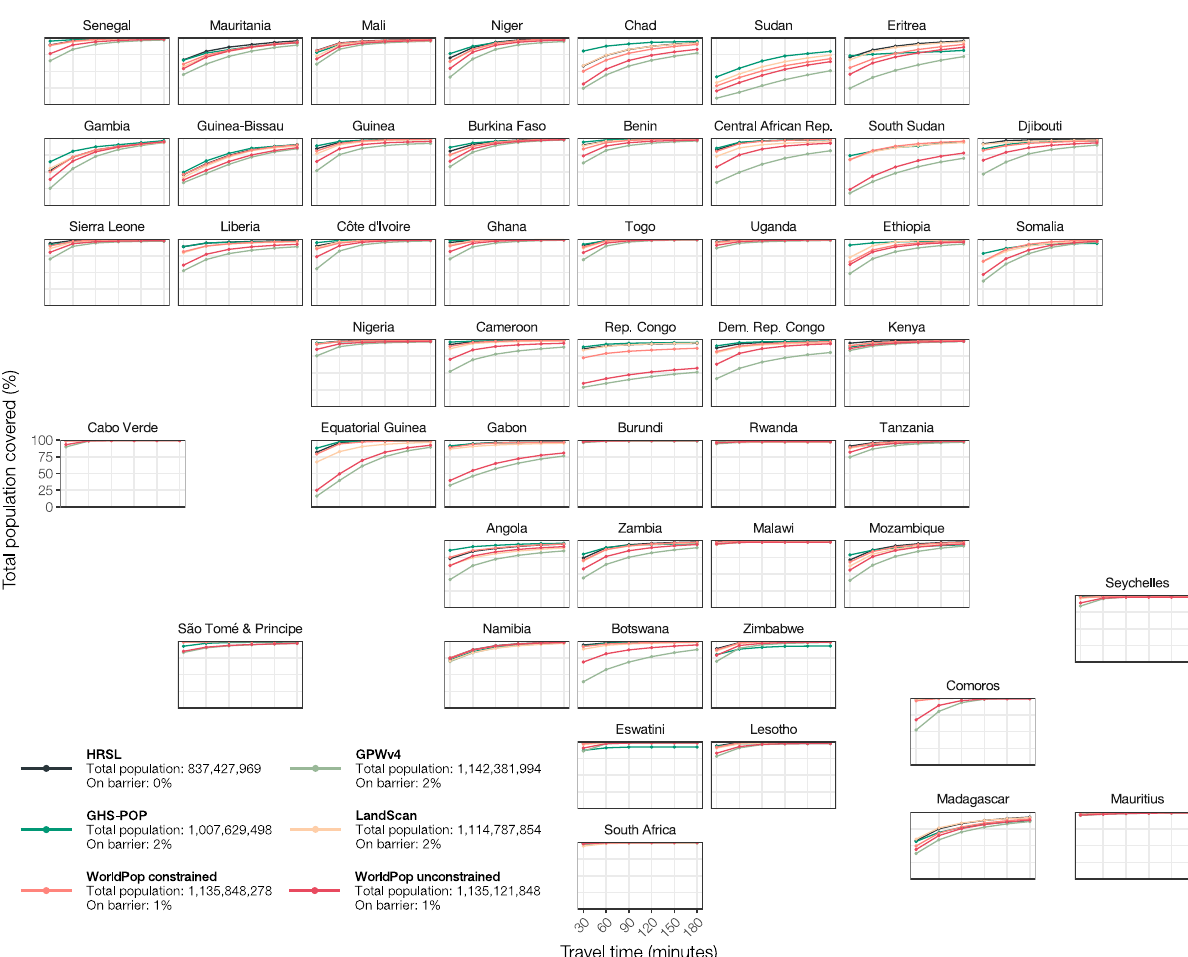
Fig. 3 Accessibility coverage for all sub-Saharan African countries. National plots for all sub-Saharan African countries comparing relative accessibility coverage statistics at 30, 60, 90, 120, 150, and 180 min travel time for the six gridded population data sets. Each plot corresponds to the relative geographical location of the country. Legend indicates the total population falling on barriers (i.e., permanent waterbodies) and thus not included in the